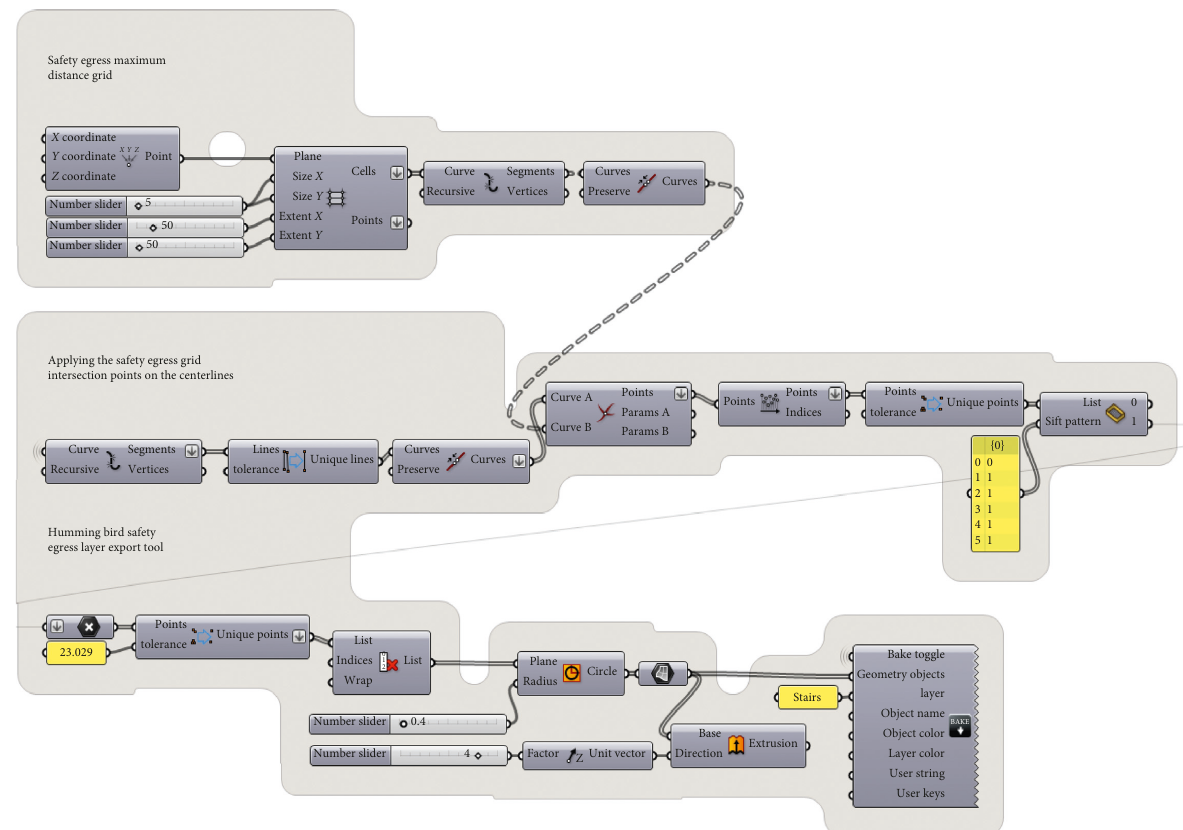
Figure 8: Algorithm for detecting optimized safety egress locations.